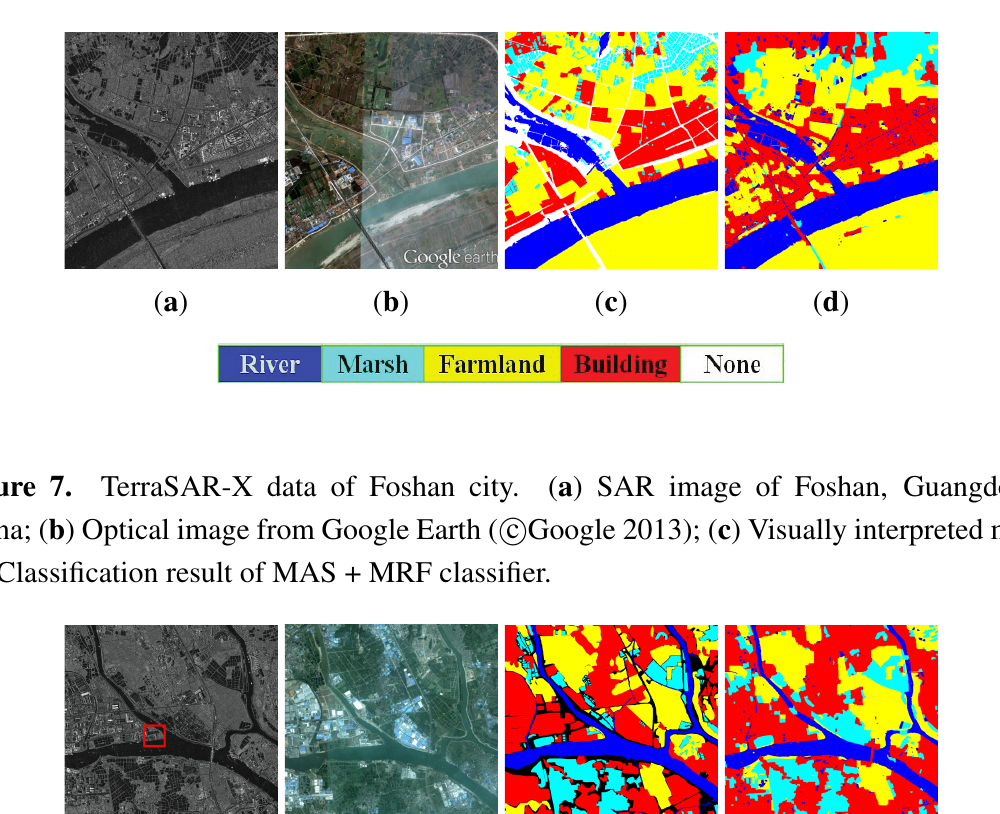
Figure 6. TerraSAR-X data of Wuhan city. ( a ) SAR image of Wuhan, Hubei, China; ( b ) Optical image from Google Earth ( c ⃝ Google 2013); ( c ) Visually interpreted map; ( d ) Classification result of MAS + MRF classifier.